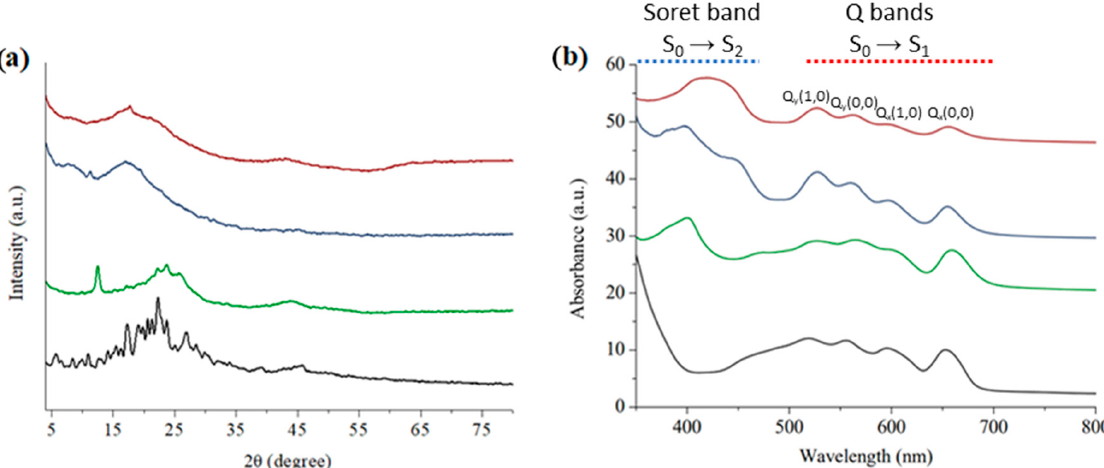
Figure 4. ( a ) X ‐ Ray powder diffraction spectrum of: Porph ‐ Br 4 (black line), COP–1 (green line), COP– Figure 4. ( a ) X-Ray powder diffraction spectrum of: Porph-Br 4 (black line), COP–1 (green line), 2 (blue line), COP–3 (purple line). ( b ) Solid state UV ‐ Vis absorbance recorded for Porph ‐ Br 4 (black COP–2 (blue line), COP–3 (purple line). ( b ) Solid state UV-Vis absorbance recorded for Porph-Br 4 line), COP–1 (green line), COP–2 (blue line), and COP–3 (red line). (black line), COP–1 (green line), COP–2 (blue line), and COP–3 (red